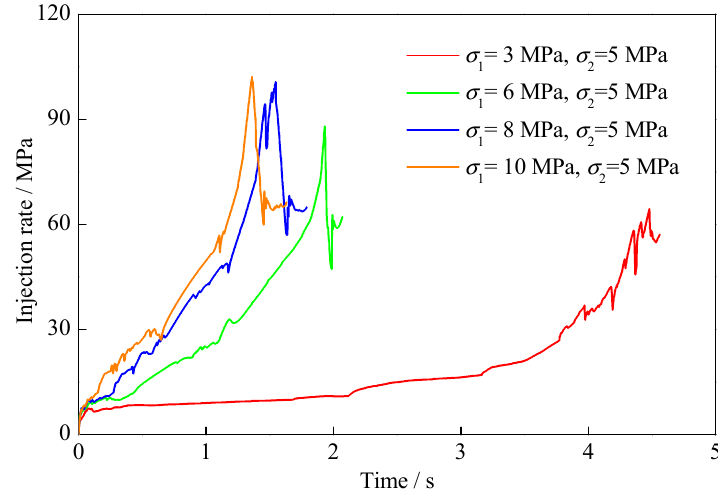
Figure 4. Injection pressure curves under different stress differences.